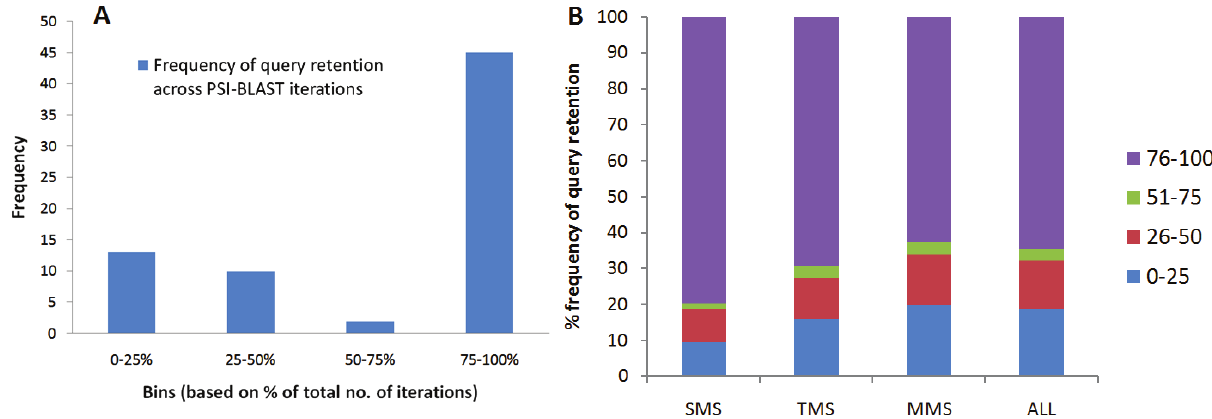
Figure 2. Frequency of retention of query until 25%, 50%, 75% or 100% of iterations of PSI-BLAST is represented as four bins (0–25%, 26–50%, 51–75%, 76–100% respectively). ( A ) Number of member queries observed per bin for 12 superfamilies and ( B ) A stacked bar plot for all percentage query retention bins observed for all superfamily members in PASS2 database and also for the different sets of SMS (Single-Member Superfamily), TMS (Two-Member Superfamily) and MMS (Multi-Member